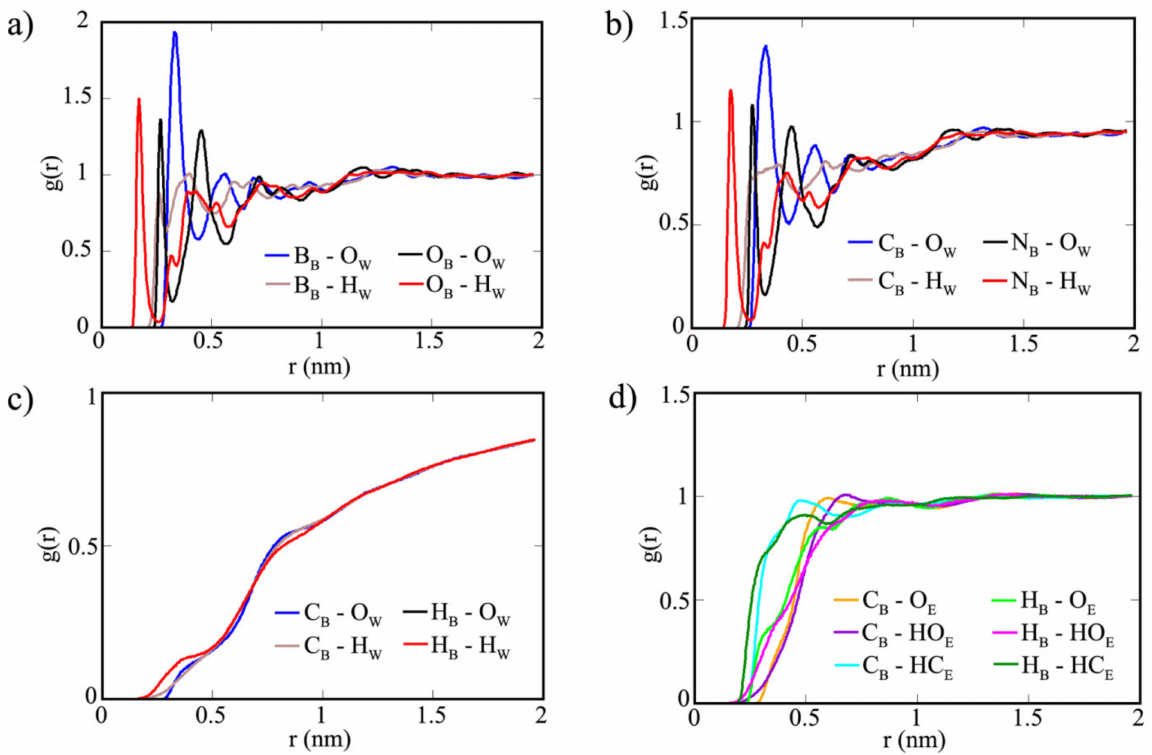
Figure 8. RDF graphs for ( a ) COF-1 (cid:48) s ring B with water, ( b ) CTF-1 (cid:48) s ring B with water, ( c ) TPG’s ring A with ethanol and ( d ) TPG’s ring B with